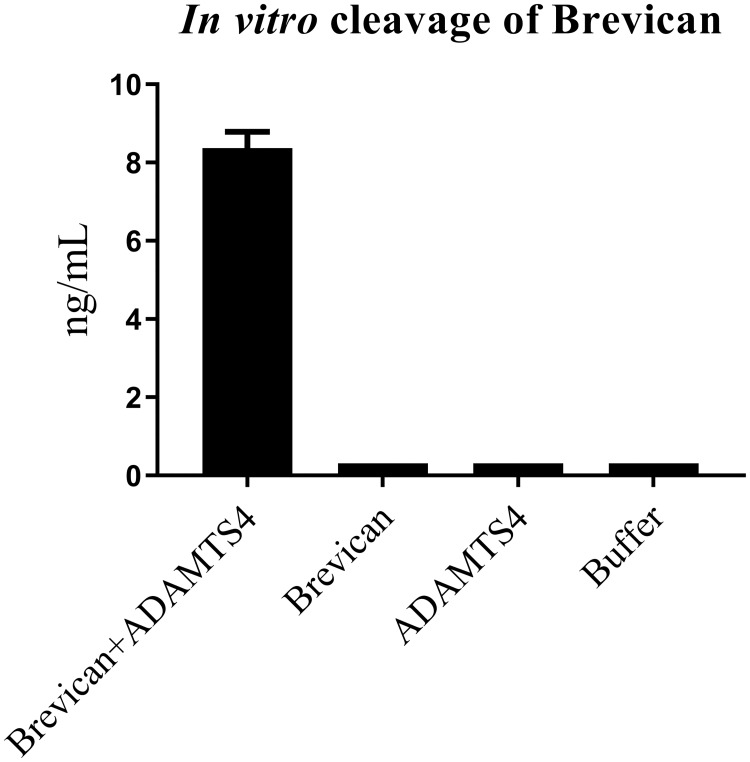
Selectivity test of Brev-A ELISA.The signal obtained by Brev-A ELISA in response to ADAMTS4-cleaved brevican, non-cleaved brevican, ADAMTS4 and cleavage buffer incubated for 72 h are shown. Concentrations below LLOD was given the value of LLOD. Shown are the mean of two determinations plotted with the standard deviation.